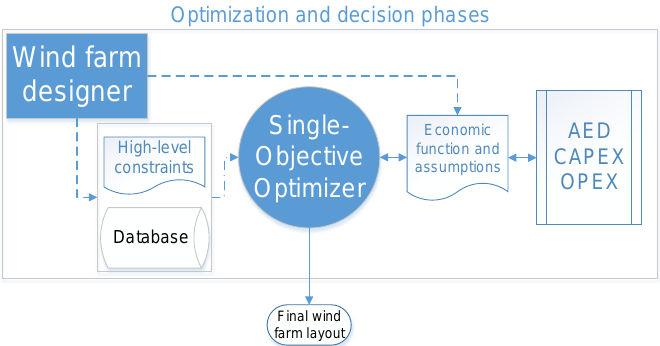
Figure 4. Flowchart of current single-objective optimization strategies. Dotted-line arrows represent input from the designer, solid-line arrows represent algorithm flow and dotted-point-line arrows represent component